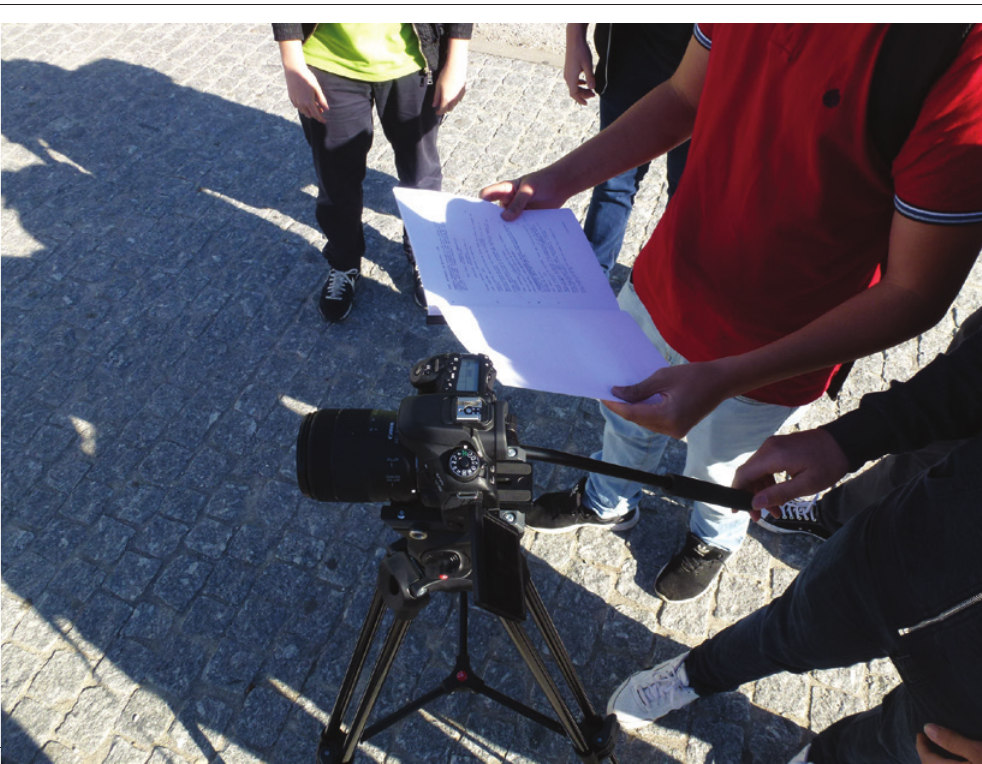
figure 4: Students shooting a